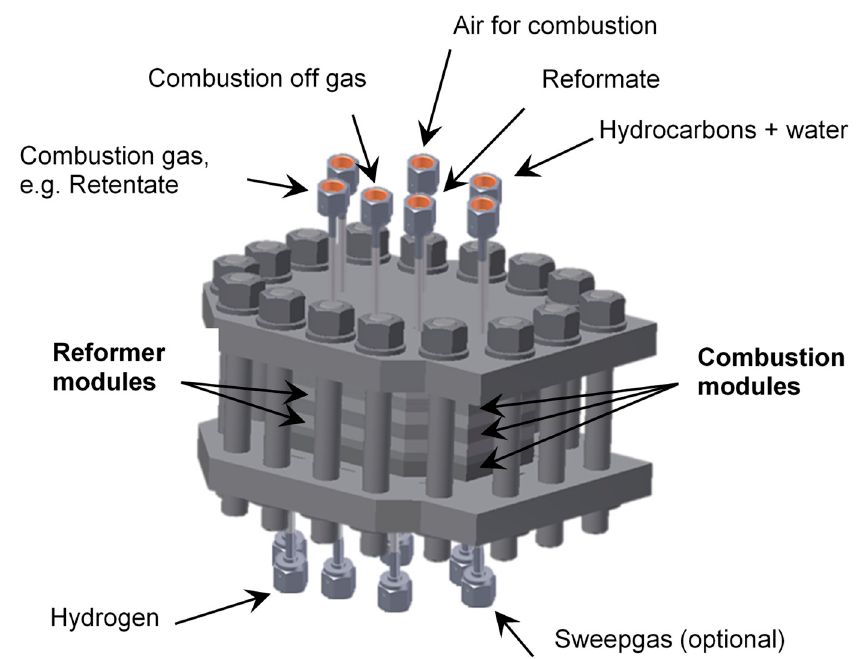
Figure 3. Schematic representation of the modular membrane reactor system with reformer and combustion modules, with inlets and outlets for reaction gases.